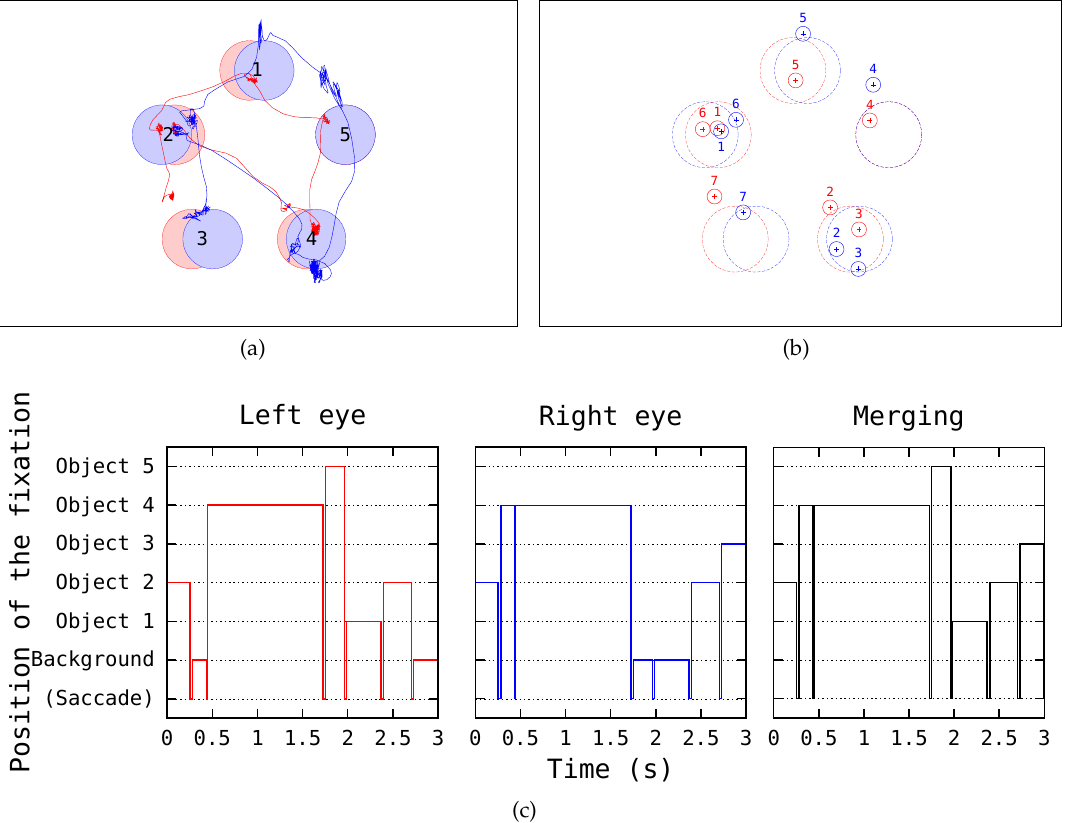
Figure 3 . Illustration of the processus of relating a fixation to an object. In (a), the curves illustrate the path of each eye, and disks illustrate the objects in each view. Red color represents the left eye’s path and the left view stimuli, while blue color represents the right eye’s path and the right view stimuli. The numbers inside each object indicate objects’ ID. (b) shows the fixations of each eye (same color as introduced previously) along with the area of detection for each object and each view. The detection areas are 10% larger than the size of the objects. The numbers indicate the temporal order of the fixations. (c) represents the position of each fixation as a function of time. Results are given for each eye, and for the merging of both